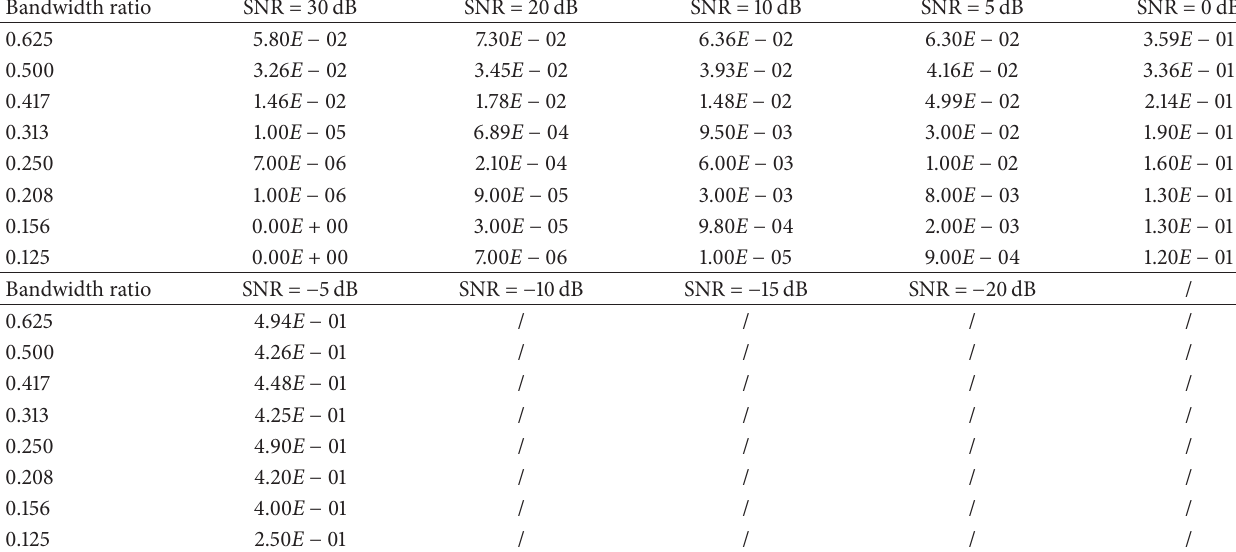
Table 3: The BER of the proposed